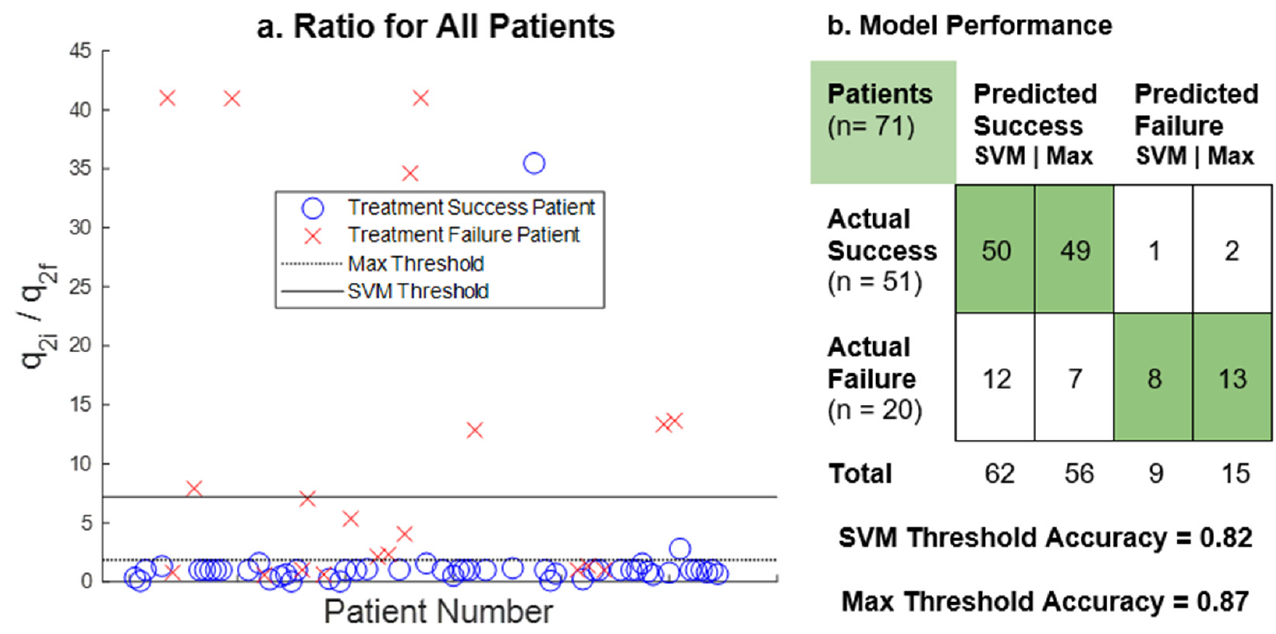
Figure 3. The predictive potential of the q 2 ratio: The scatterplot ( a ) indicates the value of the q 2 ratio for every patient in the dataset. The ratio is between the initial and final values of the q 2 parameter calculated by the mathematical model. Max (dotted line) and SVM (solid line) threshold values are shown. The confusion matrix ( b ) compares actual patient outcomes with outcomes predicted by q 2 ratio with respect to the thresholds.